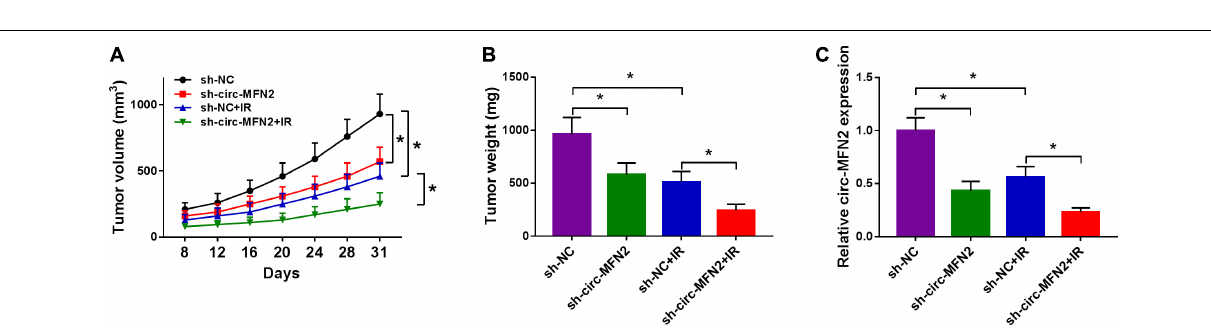
FIGURE 3 | Circ-MFN2 silencing reduced CRC tumor growth in vivo . SW480 cells transfected with sh-NC or sh-circ-MFN2 were injected into nude mice. 6 Gy radiation was given after 8 days, and then radiation was given every 4 days until 31 days. The tumor volume (A) and tumor weight (B) were measured in mice. (C) QRT-PCR was used to detect the expression of circ-MFN2 in tumors. * P <